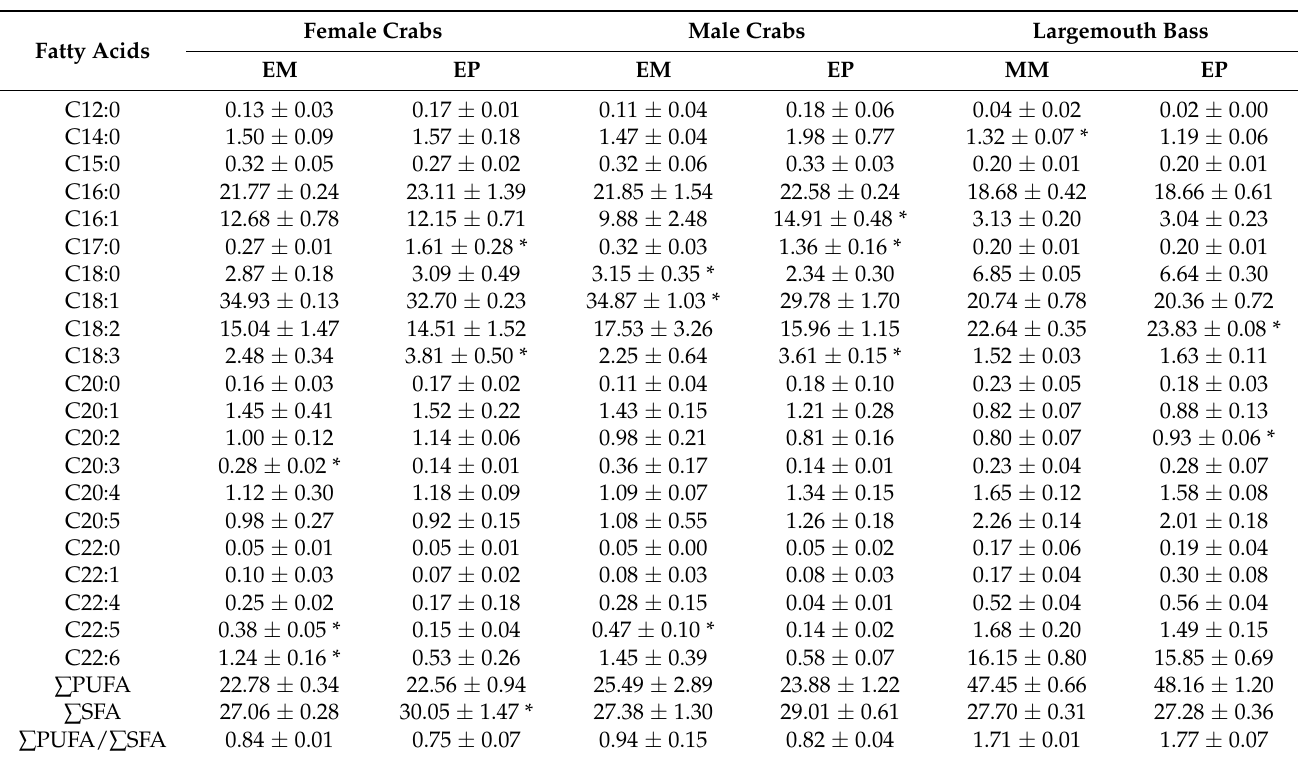
Table 4. Fatty acid composition (% total fatty acids) of edible tissues in Chinese mitten crabs and largemouth bass in the EM, MM, and EP groups. Values are means ± SD ( n =